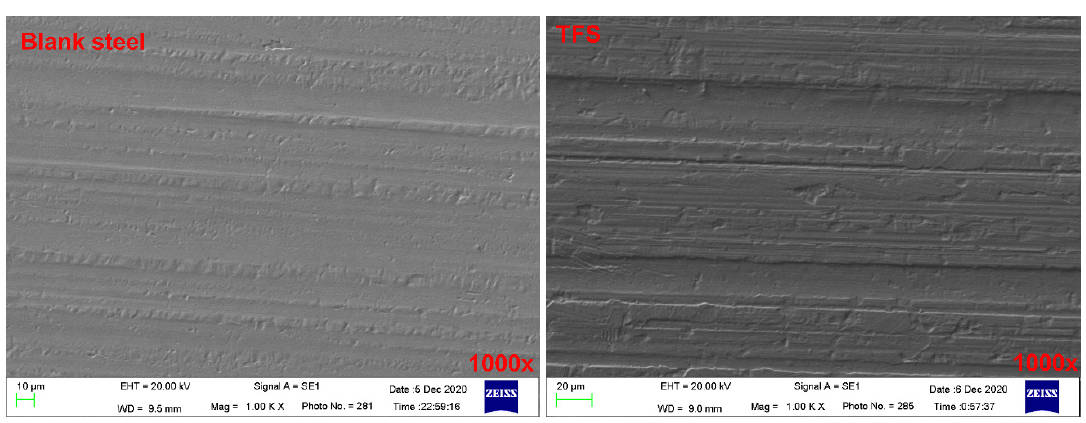
Figure 6. The SEM images of blank steel and TFS.